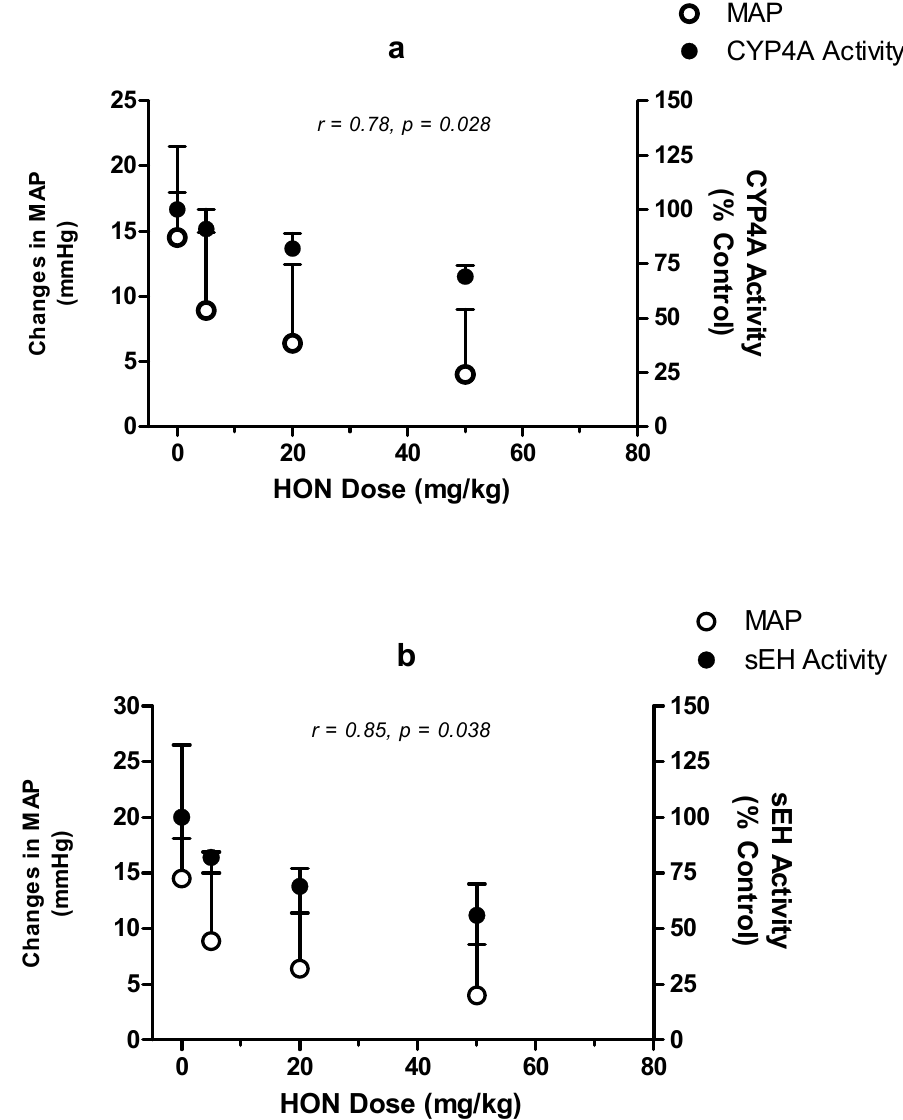
Figure 7. Correlation between changes in MAP, CYP4A activity, and sEH activity as a function of HON dose. Absolute changes in MAP (open circles) in correlation to CYP4A activity (closed circles, ( a )) or sEH activity (closed circles, ( b )) as a function of HON dose. MAP is presented as absolute change from baseline (week 0). Both CYP4A and sEH activities are presented as a percentages of control activity.